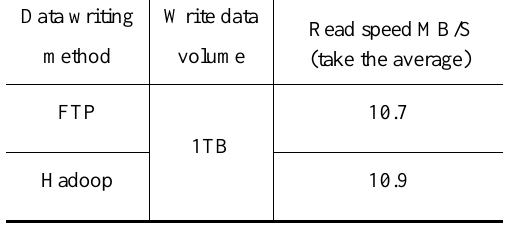
Table 1 Efficiency analysis table